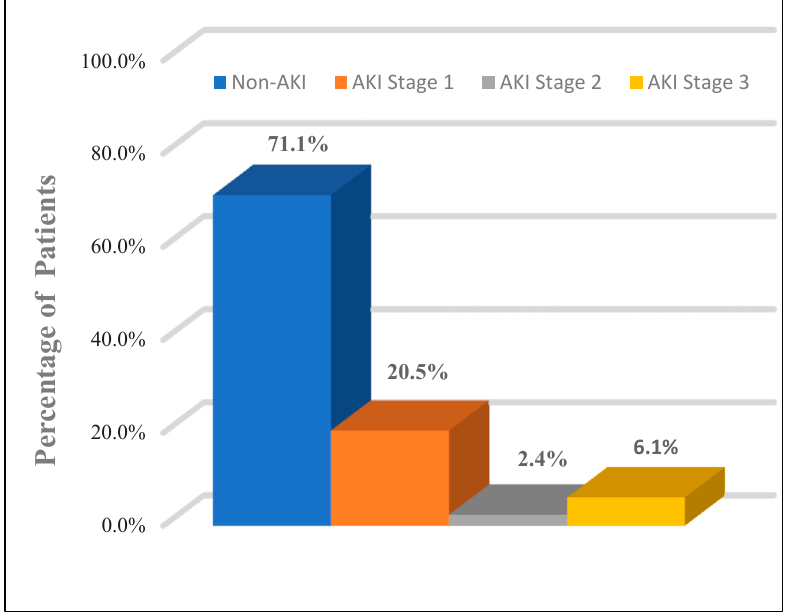
Figure 2. The proportion of patients by stages (1–3) of acute kidney injury (AKI).